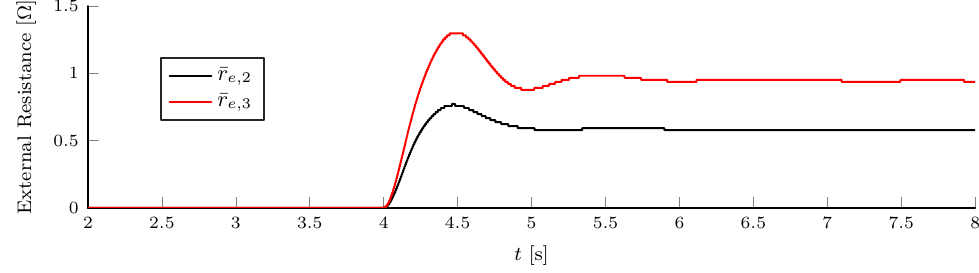
torques are balanced (all zero). For t 4 s, external resistances are applied to provide posi- ≥ tion synchronization; higher differences between primary load torque and secondary load torque result in a higher value of external resistance to ensure steady-state position syn-